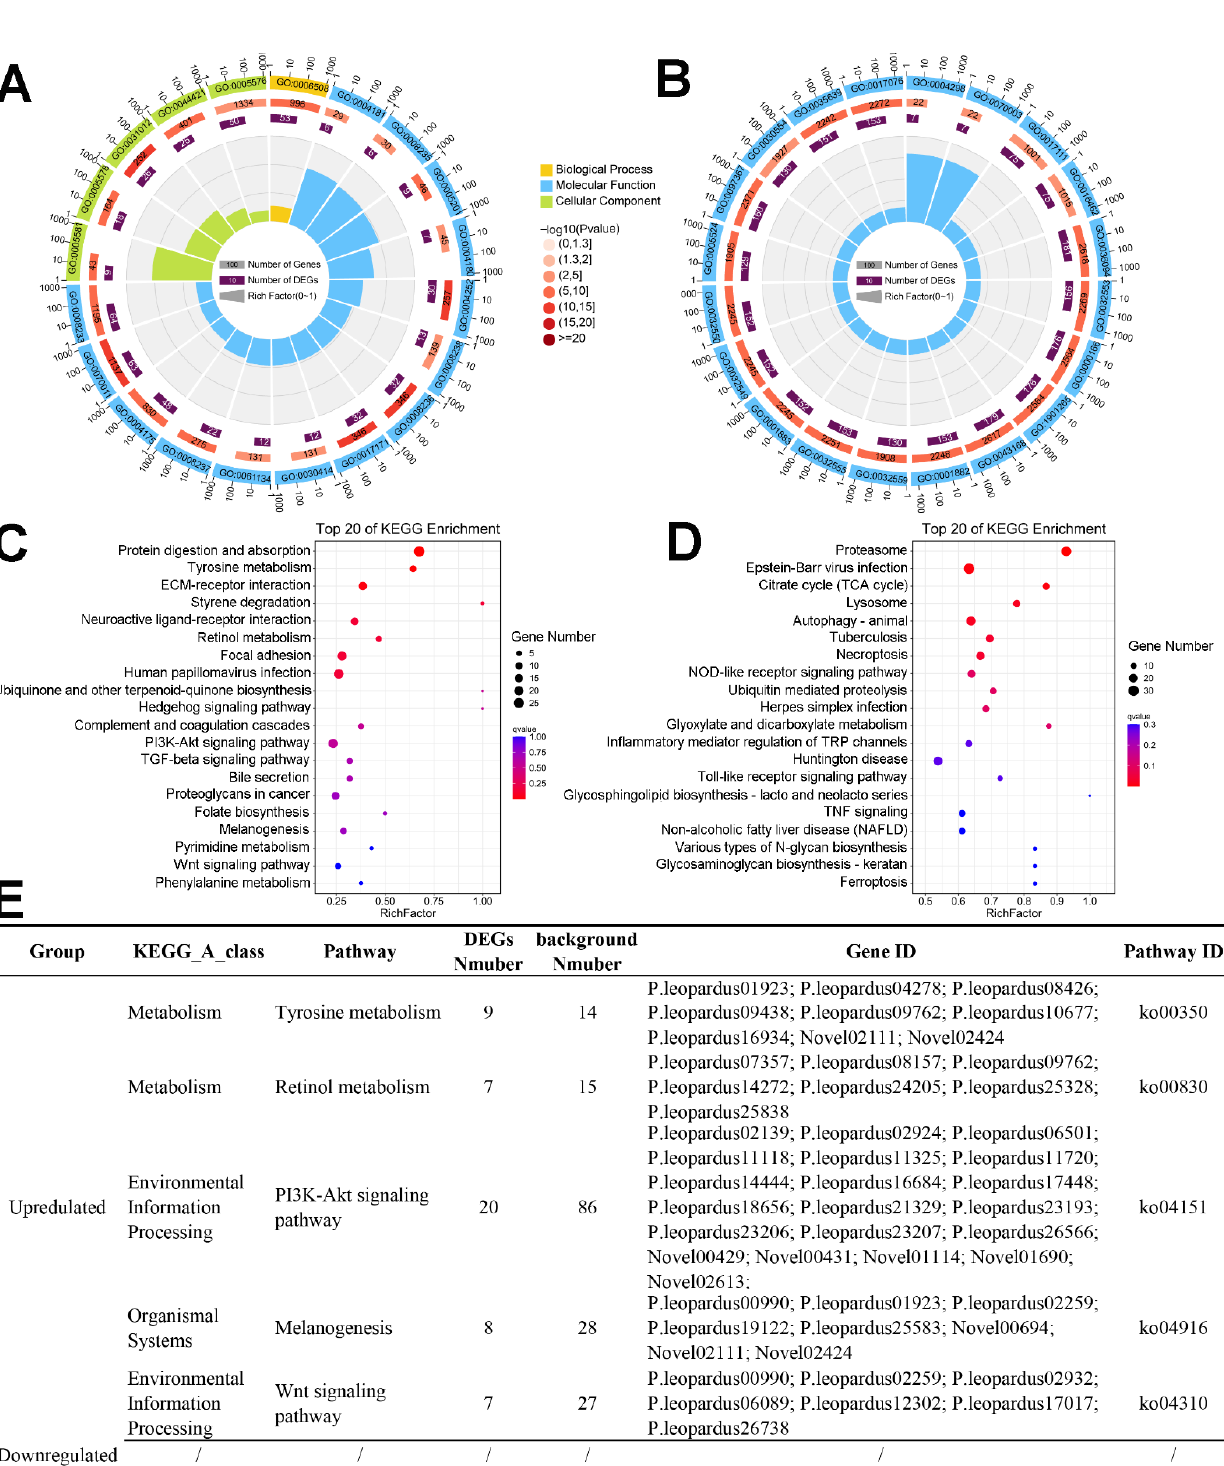
Figure 7. GO and KEGG enrichment results of DEGs. ( A ) GO terms of upregulated genes. ( B ) 20 GO terms of downregulated genes. ( C ) KEGG pathways of upregulated genes. ( D ) KEGG pathways of downregulated genes. ( E ) Melanogenesis-related